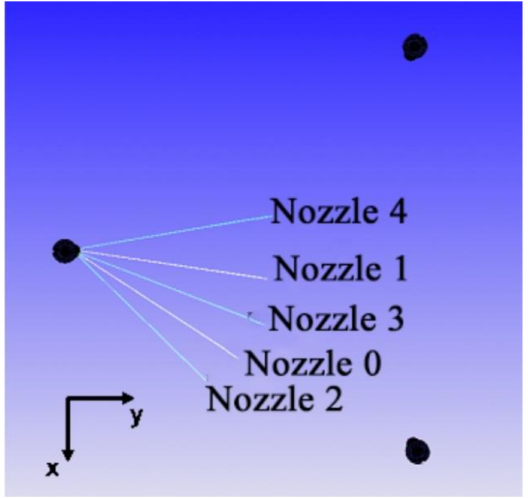
Figure 1. Schematic diagram of the x–y plane of the injectors and the injection direction.